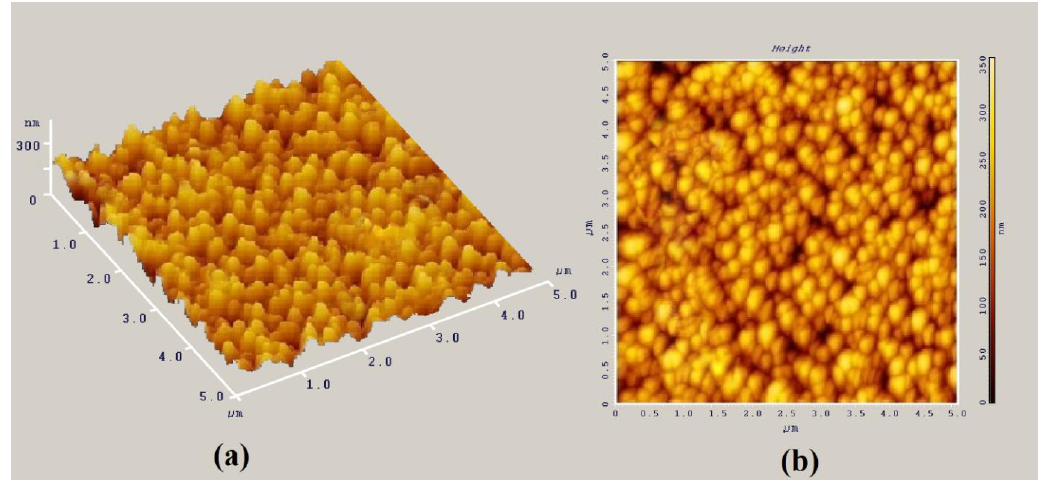
Fig. 3. (a) 3-D and (b) 2-D AFM images of the surface of BSS2 thin film. (532) planes, respectively. Comparing this pattern